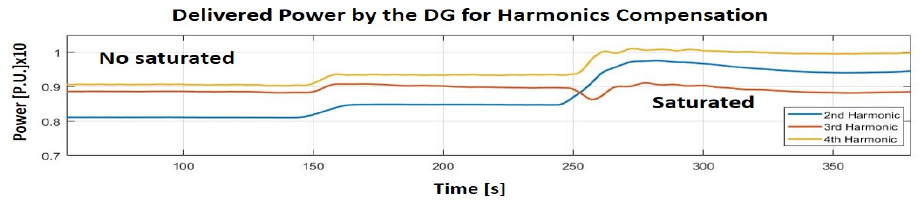
Figure 8. Power and currents delivered by the PCC and the DG for case 4: ( a ) time–domain PCC and DG active power signals, ( b ) total power supplied by the DG, ( c ) no saturated and ( d ) saturated measurements at the PCC.